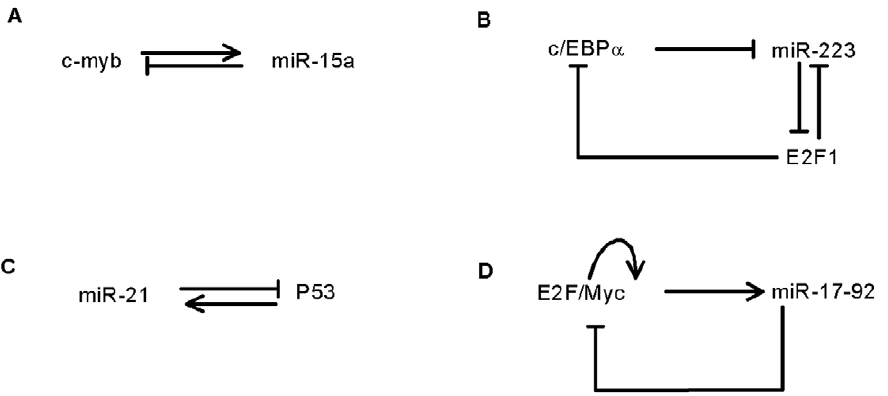
Figure 1. Examples of the interlinked positive and negative feedback loops in genetic networks. (A) The interaction between C-myb and miR-15a in human hematopoietic cells. (B) The regulation between cell cycle E2F1 and mizr-223 in acute myeloid leukemia. (C) MiR-21 targets p53 in Glioblastoma cells, and (D) the feedback loops involving miR-17-92, E2F and Myc in cancer networks.